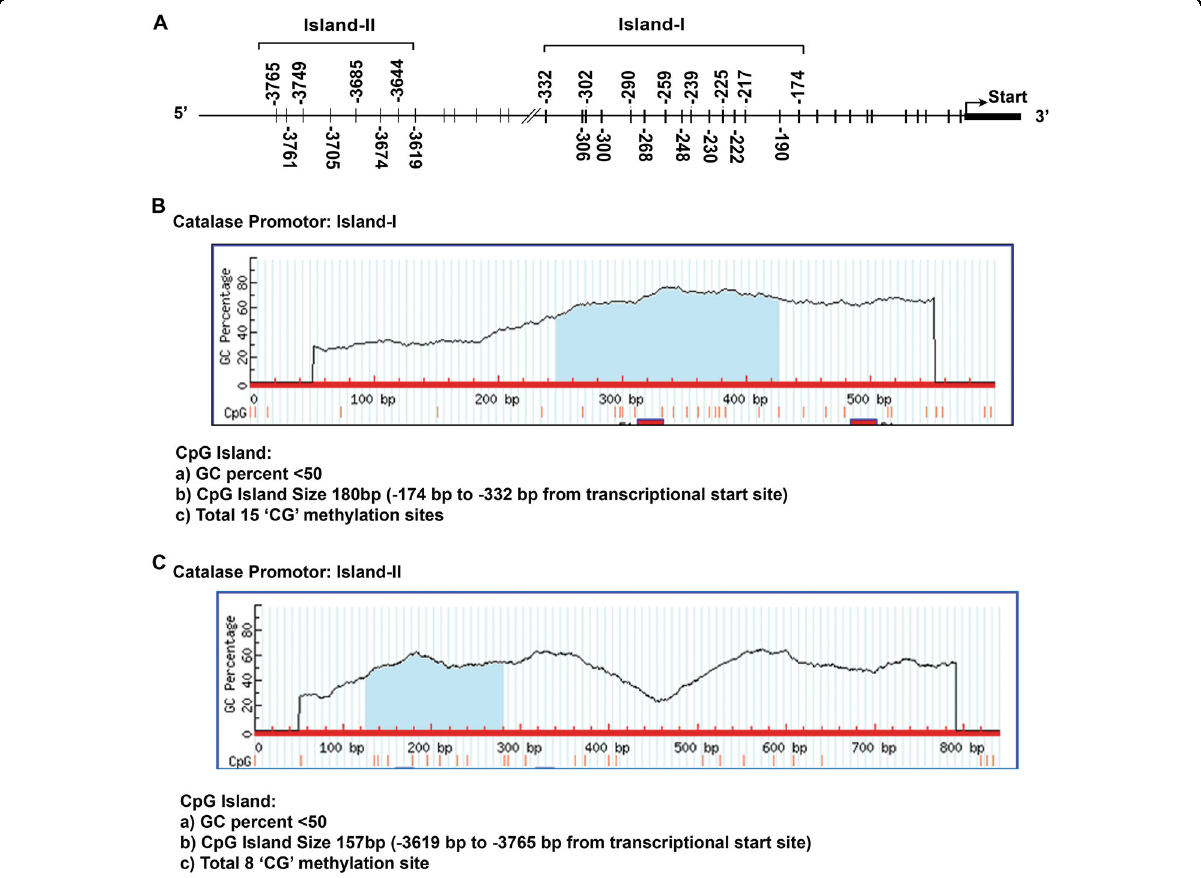
Fig. 3 Diagram of catalase gene promoter and prediction of putative CpG-Islands. A The entire human catalase promoter was analyzed for the prediction of putative CpG sites for methylation (http://www.urogene.org/cgi-bin/methprimer/methprimer.cgi). Two potential CpG-Islands were detected in the catalase promoter: a proximal (Island-I; nt − 174 to − 332) and a distal (Island-II; nt − 3619 to − 3765) as shown by line drawing for putative methylation sites. B , C These diagrams are showing the GC contents, putative methylation sites, and positions in the human catalase promoter as per the